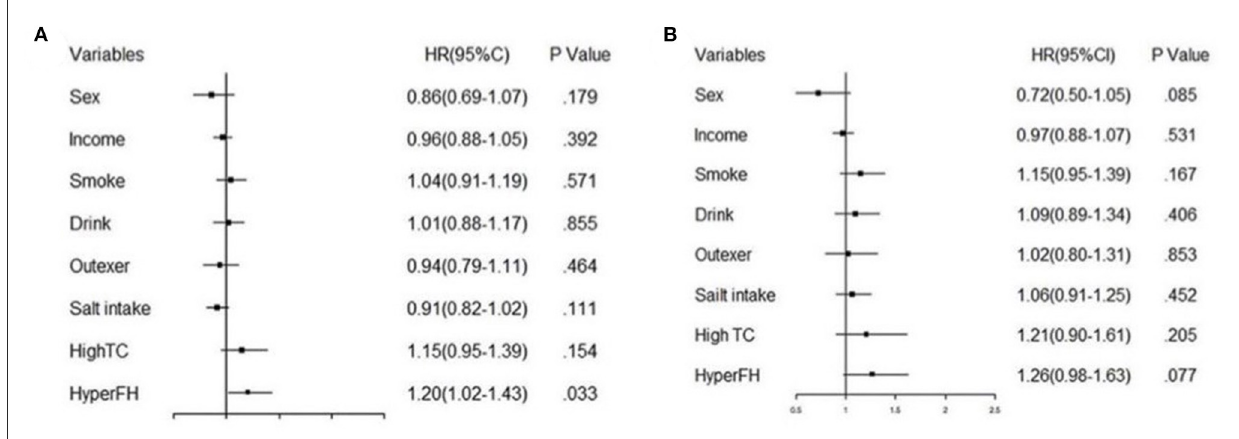
FIGURE7 The forest plot of fully adjusted Cox model analysis of age subgroups. (A) shows the result of subgroup under 60 years old and (B) illustrates the result of subgroup over 60 years old.